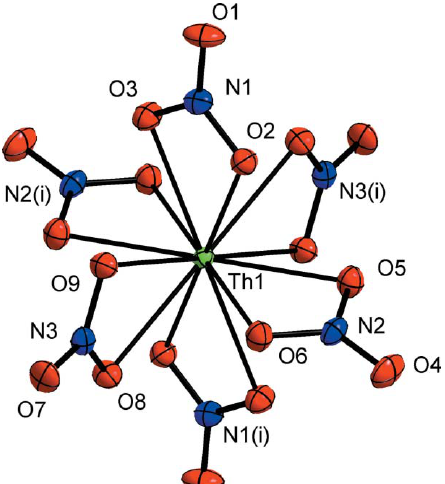
Figure 1 The [Th(NO 3 ) 6 ] 2 (cid:2) -anion of the title compound. Displacement ellipsoids are drawn at the 70% probability level. Labelling for symmetry- equivalent oxygen atoms is omitted for clarity. [Symmetry code: (i) (cid:2) x , (cid:2) y + 1, (cid:2) z